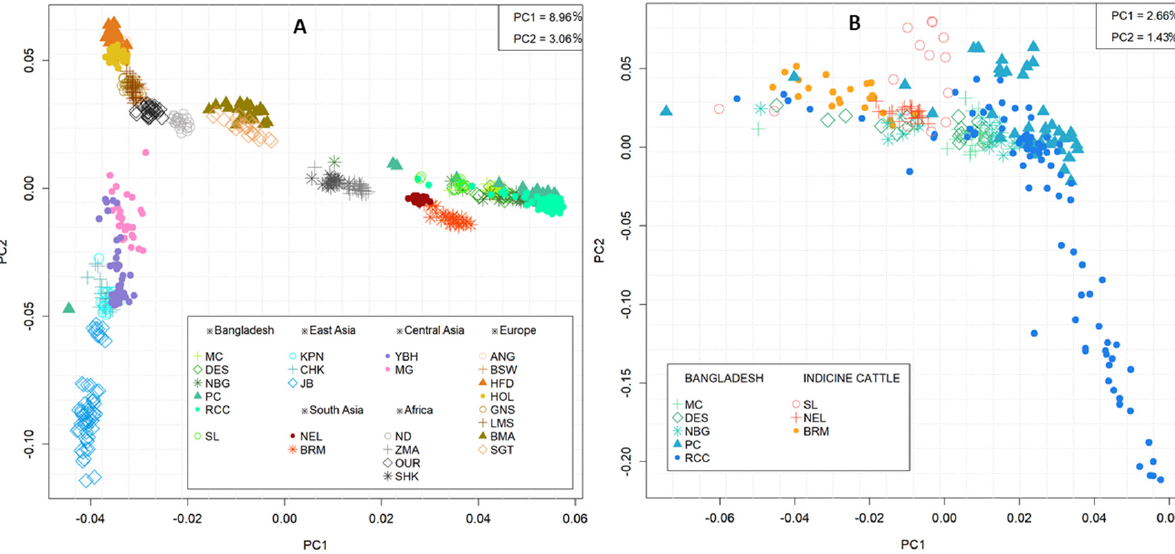
Figure 2. Principal component analysis of the first two axis in 723 samples from 25 cattle populations distributed worldwide ( A ) and 264 samples from six Bangladeshi Indigenous cattle along with two other indicine breeds ( B ). Cattle populations are labelled as Sahiwal (SL), Munshiganj (MC), Non-descript Deshi (DES), North Bengal Grey (NBG), Pabna (PC), Red Chittagong (RCC), Brahman (BRM), Nellore (NEL), Korean Hanwoo (KPN), Korean Chikso (CHK), Korean Jeju Black (JB), Yianbian (YBH), Mongolian (MG), Angus (ANG), Brown Swiss (BSW), Hereford (HFD), Holstein (HOL), Guernsey (GNS), Limousine (LMS), Santa Gertrudis (SGT), Beefmaster (BMA), N’Dama (ND), Oulmes Zaer (OUR), Zebu Madagascar (ZMA), and Sheko (SHK).